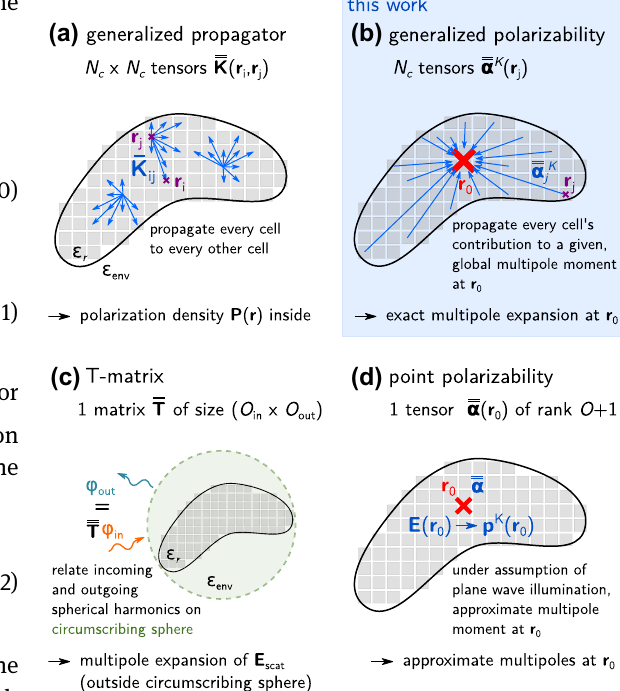
than saving the generalized field propagators for a larger set of